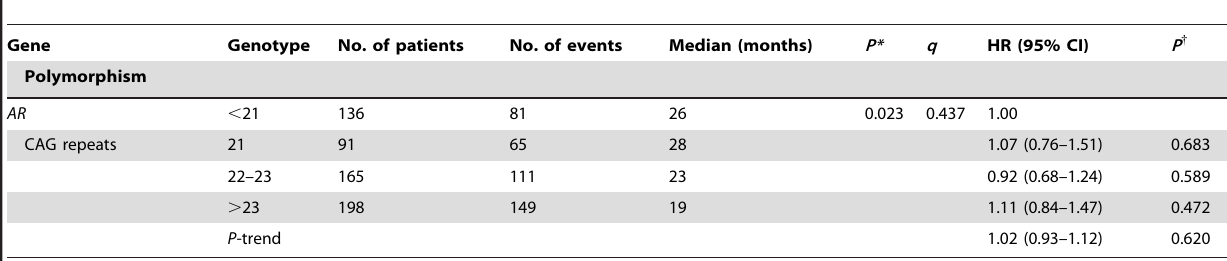
Table 2. Genotyping frequencies and the association of genotype with disease progression during ADT.